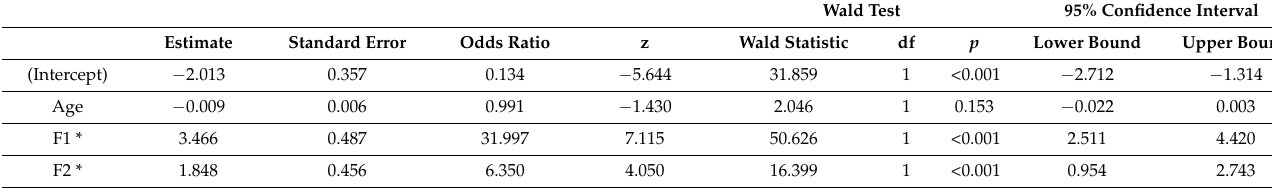
Table 4. Logistic regression coefficients.